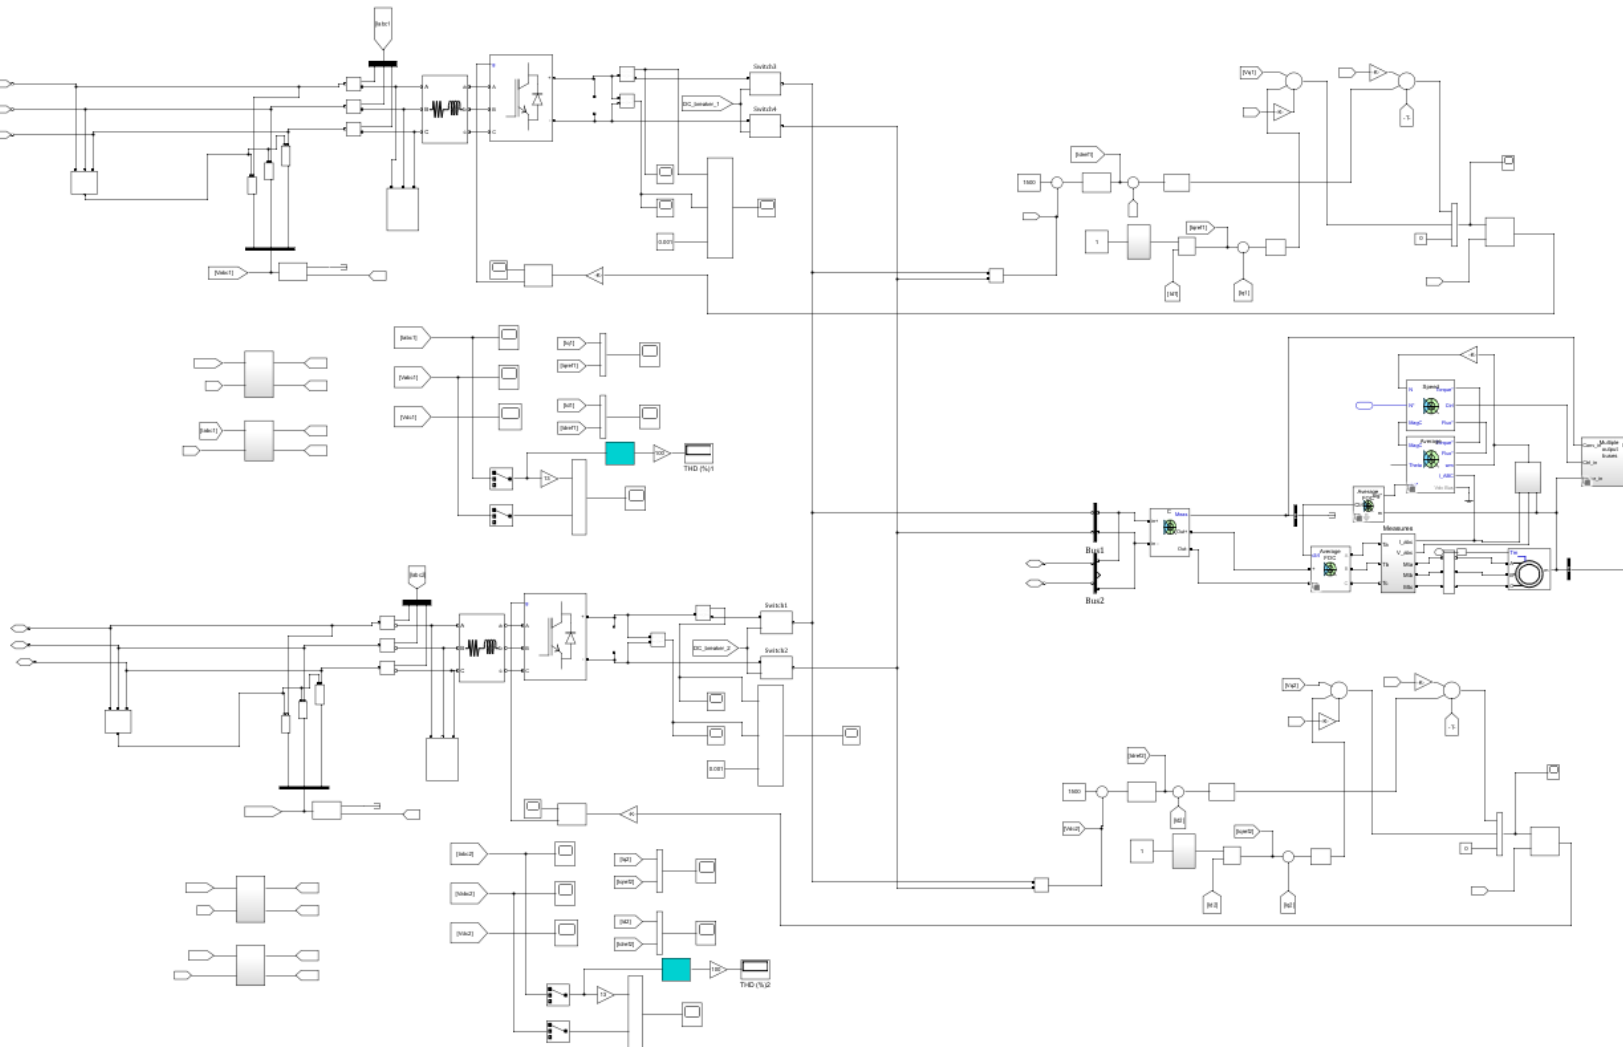
Figure 16. Simulation model of converter and propulsion motor for generator–battery hybrid system architecture results.